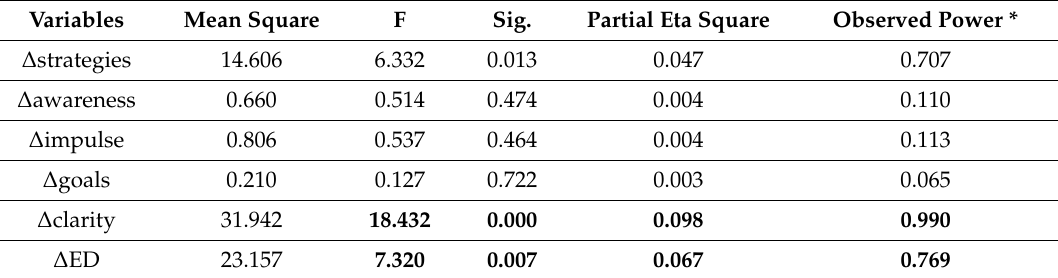
Table 7. Di ff erences between groups (one-way MANOVA); tests of between-subjects e ff ects. Gr. 1: chronic disease, n = 137; Gr. 2: healthy persons, n =